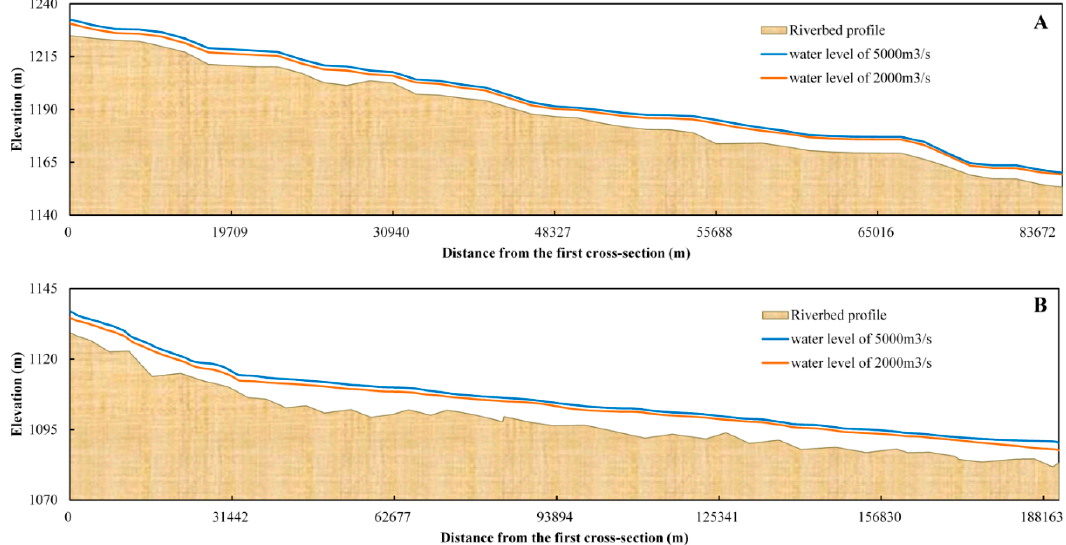
Figure 7. Water surface profiles of the moderate frequent flooding events with different discharge values in the: ( A ) Weining Reach; and ( B ) Qingshi Reach of the NRYR.